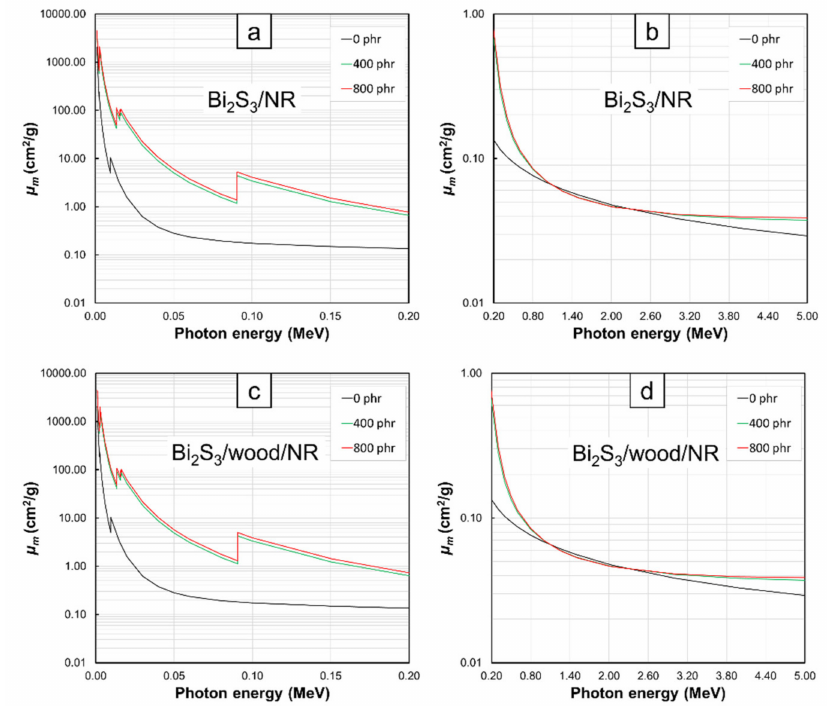
Figure 2. µ m values of ( a , b ) Bi 2 S 3 /NR and ( c , d ) Bi 2 S 3 /wood/NR composites with filler contents of 0, 400, and 800 phr, determined at photon energies of ( a , c ) 0.001–0.2 MeV and ( b , d ) 0.2–5 MeV using XCOM. Raw data are provided in the Supplementary Materials (Tables S1, S6, S7, S8, S13, and S14).